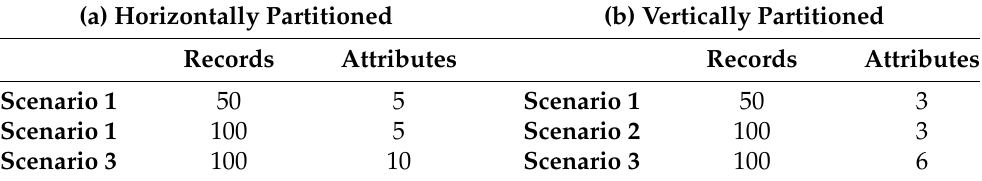
Table 3. Experiment